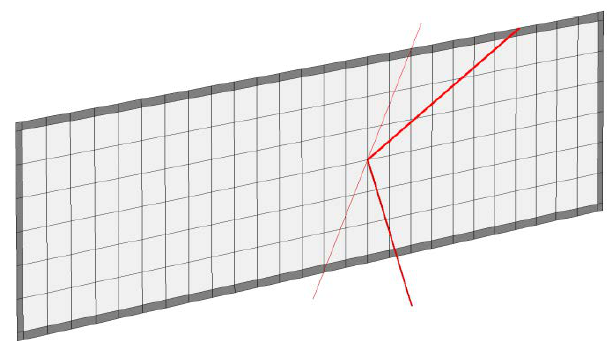
Figure 2: Illustration of the search pattern. Each cross point p is examined in order to find a reflection